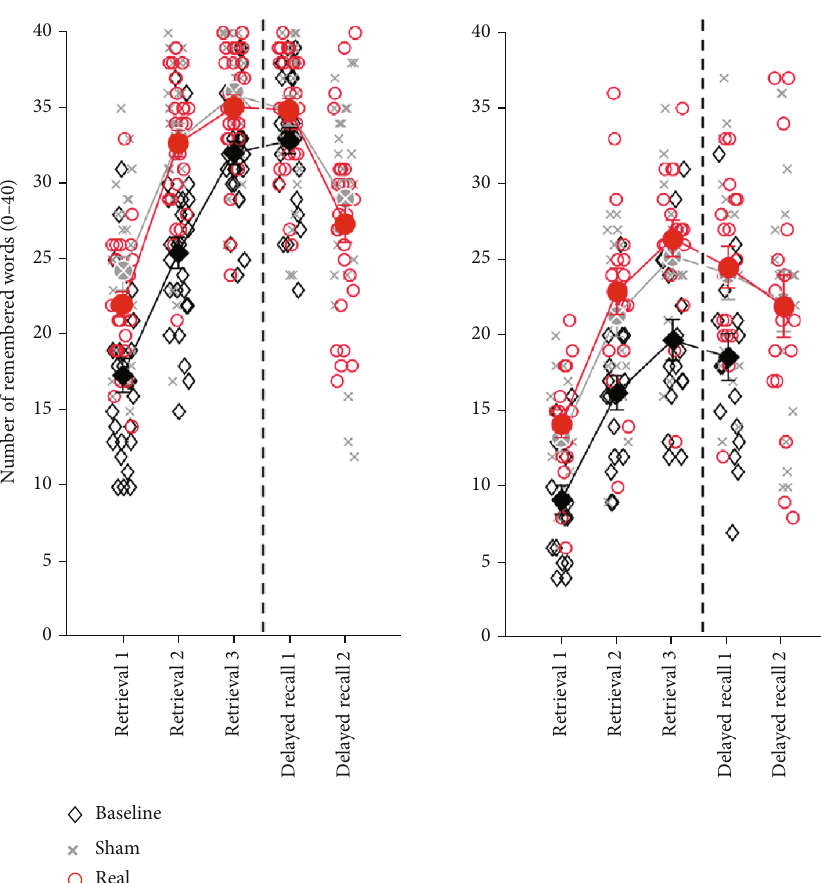
Figure 2: Performance in verbal episodic memory task. Number of words recalled during encoding and retrieval phase according to session (black diamonds: baseline; grey crosses: sham stimulation; red circles: real anodal tDCS) in young and elderly participants. Note that the delayed recall 2 was only conducted after MR sessions and not for the baseline session. Large symbols: mean ± SE ; small symbols: performance of single